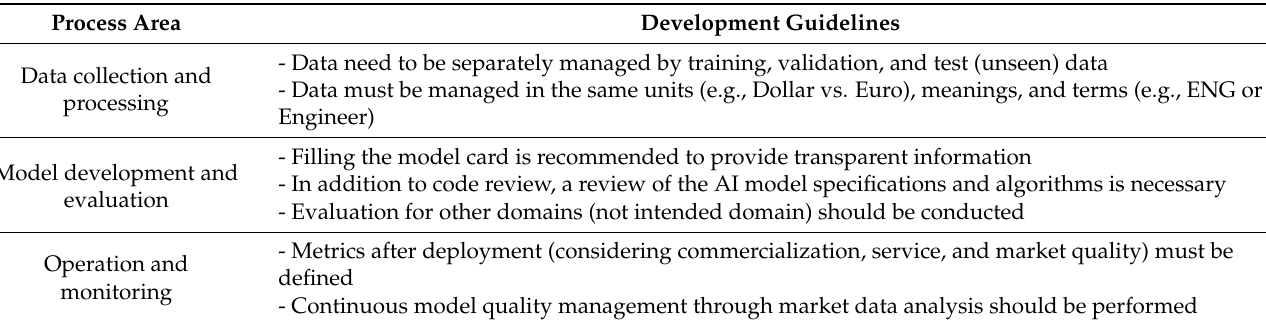
Table 4. Example AI development guidelines.